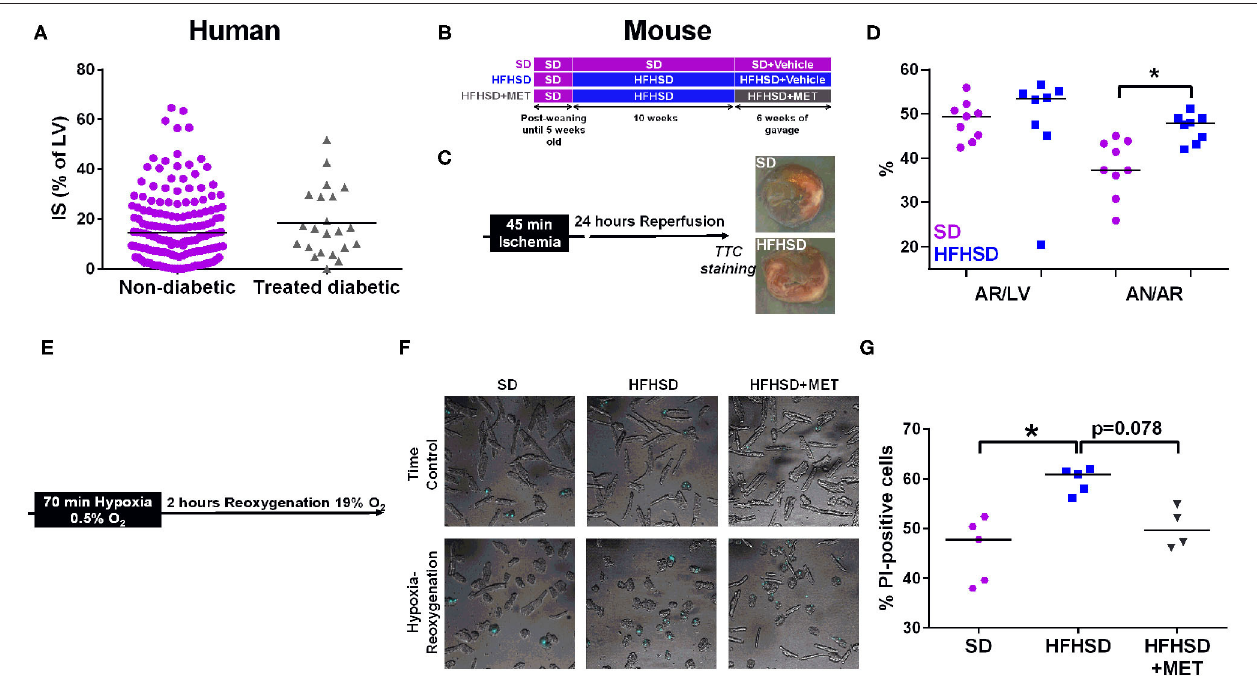
FIGURE 1 | Effect of diabetes on infarct size and cardiomyocyte cell death in humans and mice. (A) Measurement of infarct size (IS) as a percentage of the left ventricle (LV), assessed by MRI one month post-MI in patients (155 non-diabetics vs. 22 diabetics). p = ns. (B) Study design of the diet groups SD and HFHSD together with the oral gavage of Metformin (MET) or Vehicle for the last six weeks of feeding. (C) in vivo model of myocardial infarction in mice consists in 45min of ischemia induced by ligation of the left descending coronary artery followed by 24h of reperfusion before assessment of infarct size. Representative images of infarct size are depicted for each group. (D) Measurement of the area at risk (AR/LV), expressed as a percentage of area at risk (AR) over left ventricle (LV), and of the infarct size (AN/AR), calculated as a percentage of area of necrosis over (AN) area at risk. n = 9 SD and 8 HFHSD, * p < 0.05. (E) Timeline of the hypoxia-reoxygenation protocol: hypoxia is induced for 70min at 0.5% O 2 followed by reoxygenation at 19% O 2 for 2h before assessment of cell death. (F) Representative images of combined white light and propidium-iodide (in blue) cardiomyocytes from SD, HFHSD, and HFHSD + MET mice, in normoxic condition (TC) and after hypoxia-reoxygenation (HR). (G) Assessment of cell death by propidium iodide (PI) staining after hypoxia-reoxygenation in cardiomyocytes from SD, HFHSD, and HFHSD + MET mice ( n = 4-5/group). * p <